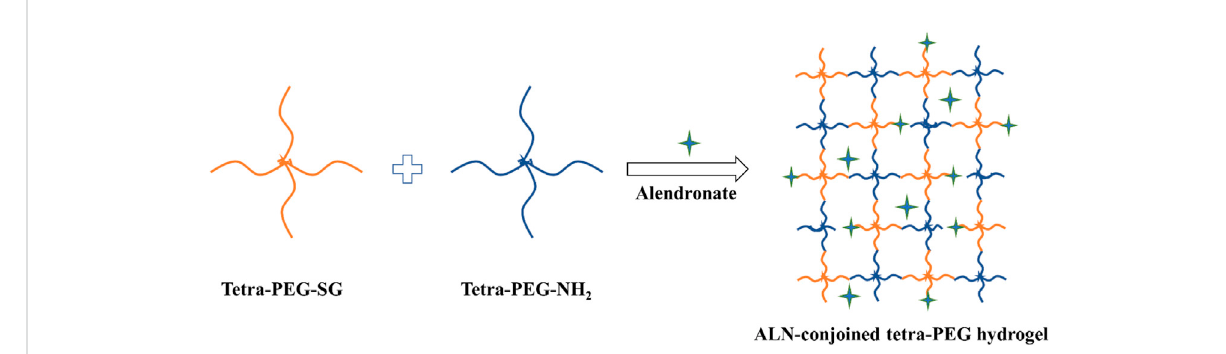
FIGURE 1 Schematic illustration of the fabricated ALN-conjoined tetra-PEG